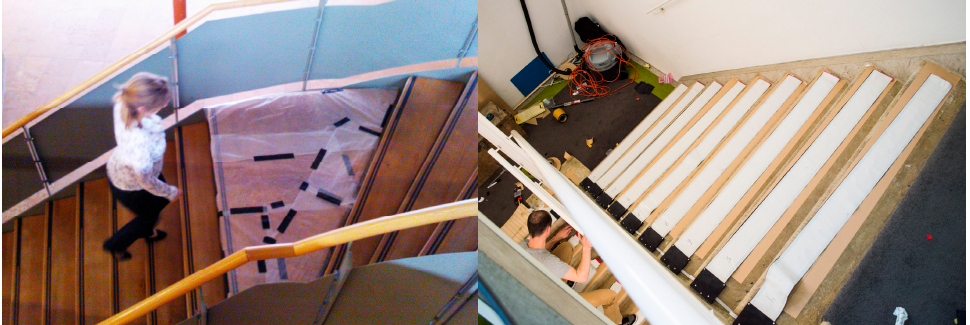
Figure 5. From the first exploration to a sustainable EDL that can last for 6 months, which allowed